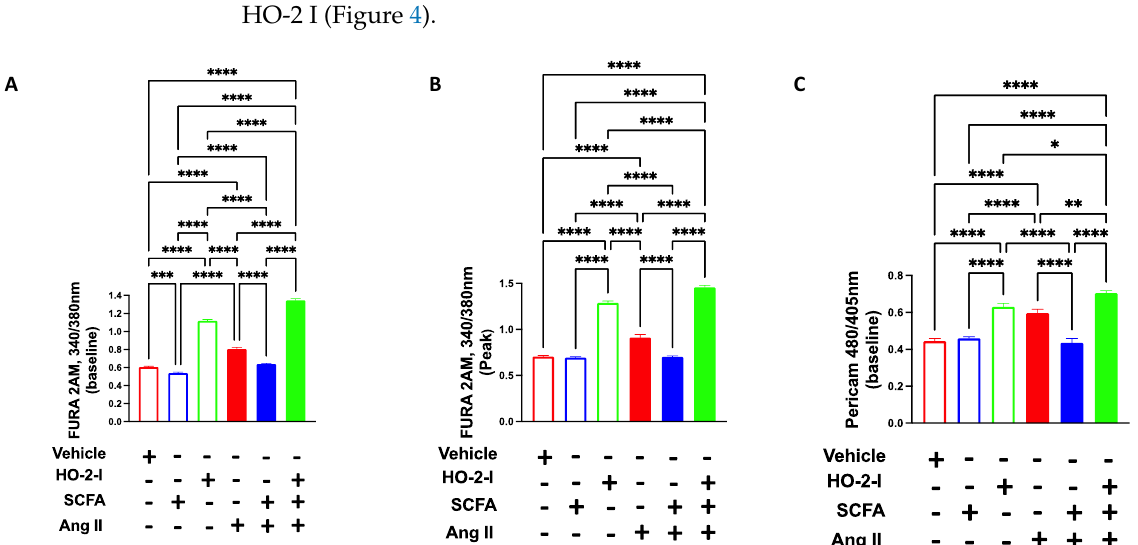
Figure 4. SCFAs reduce Ang-II-induced Ca 2+ increase by mediating HO-2. Cytosolic Ca 2+ at baseline ( A ), at peak ( B ), and mitochondrial Ca 2+ ( C ) showing that Ang-II-induced increases in Ca 2+ , in brain microvascular endothelial cells were reversed by the SCFAs/HO-2 axis. * p < 0.05; ** p < 0.01; *** p < 0.001; **** p < 0.0001. N = 3–5. SCFAs: short-chain fatty acids; Ang II; angiotensin II; HO-2 I: heme oxygenase 2 inhibitor; and FURA 2AM and Pericam: Ca 2+